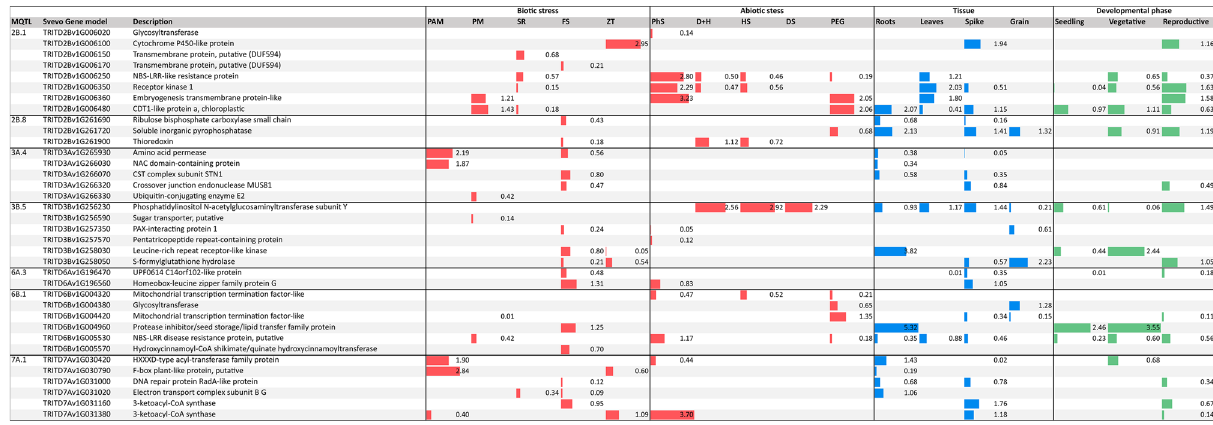
Figure 4. Expressed genes involved in biotic and abiotic stress, in different tissues and developmental phases for each